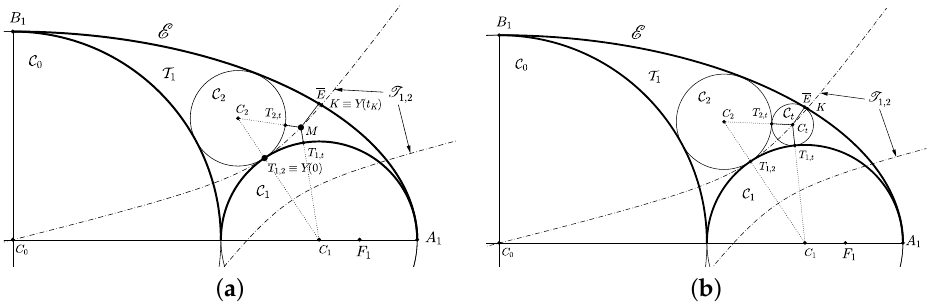
Figure 5. ( a ) Determination of center C t of sprout circle C t and circle C t . ( b ) Packing of circle C t